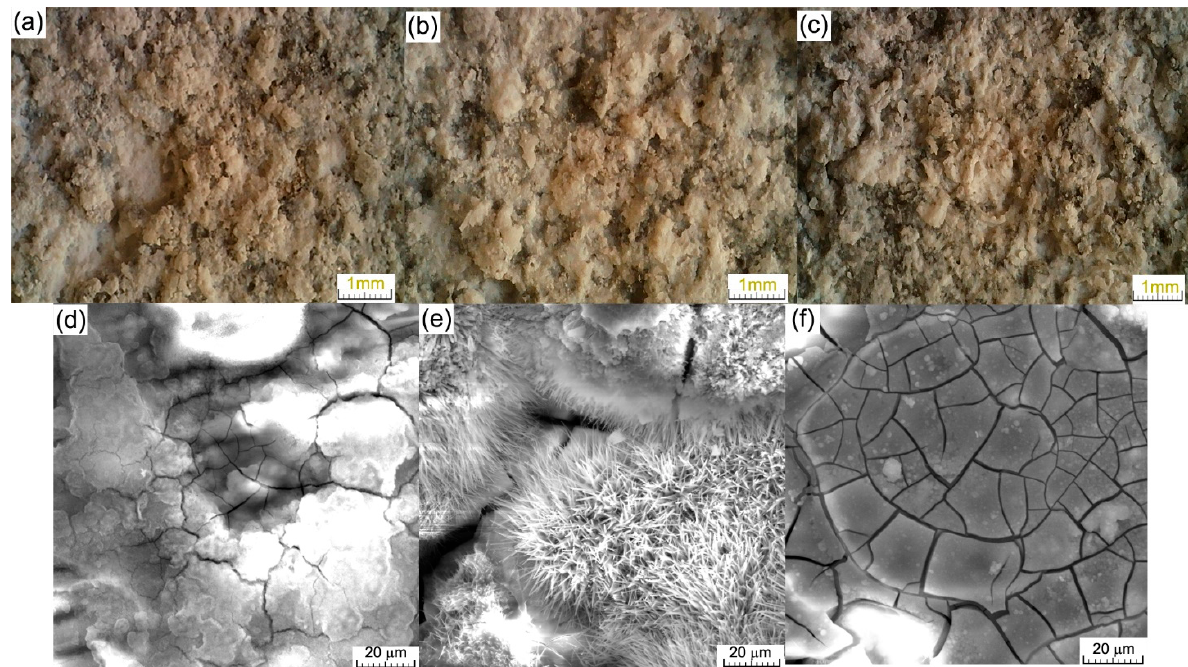
Figure 6. Surface statement after immersion in SBF at 37 °C with light microscopy images in ( a – c ) and electron scanning microscopy in ( d – f ).